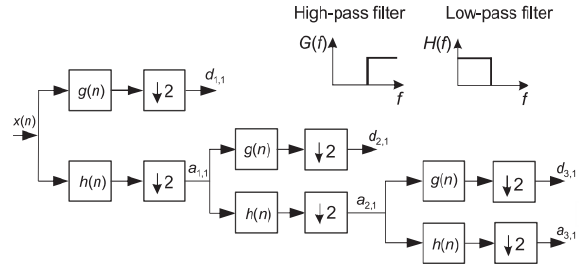
Fig. 6. Configuration window of the Multiresolution Analysis module in the LabVIEW environment.